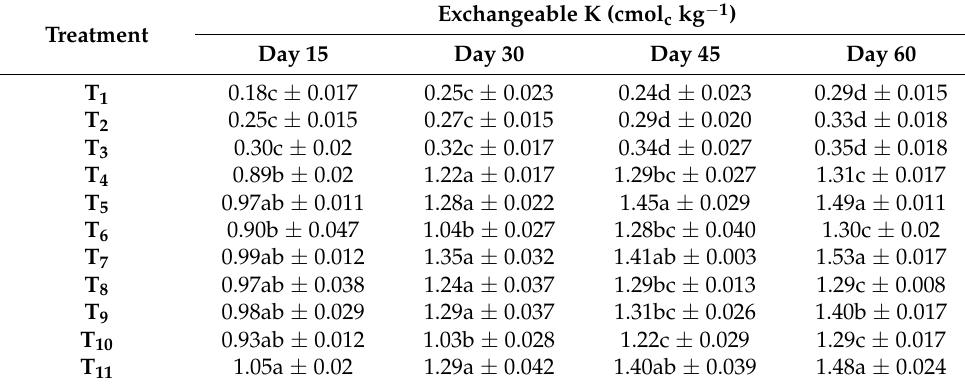
Table 8. Effect of RHB, EFBB, and dolomitic limestone treatments on soil exchangeable